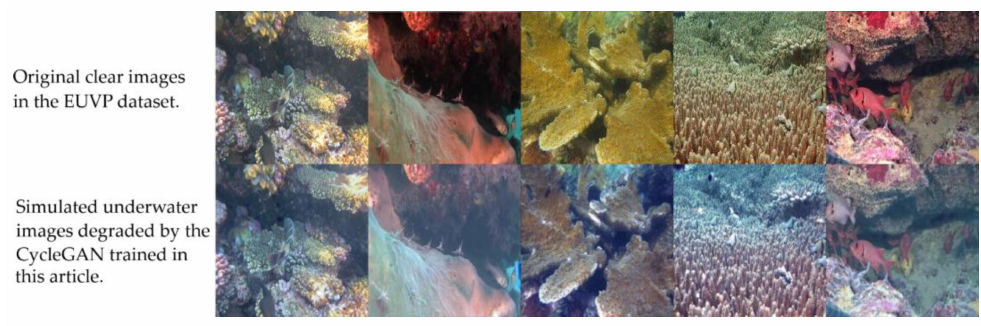
Figure 8. Degradation of enhancement results. Table 2. The statistical UIQM values of each training time for EnlightenGAN. EnlightenGAN Training Times